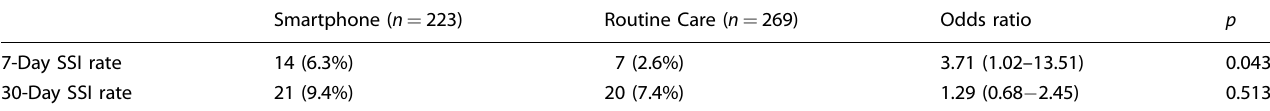
Table 2. Time-period of diagnosis of surgical-site infection in the trial arms.